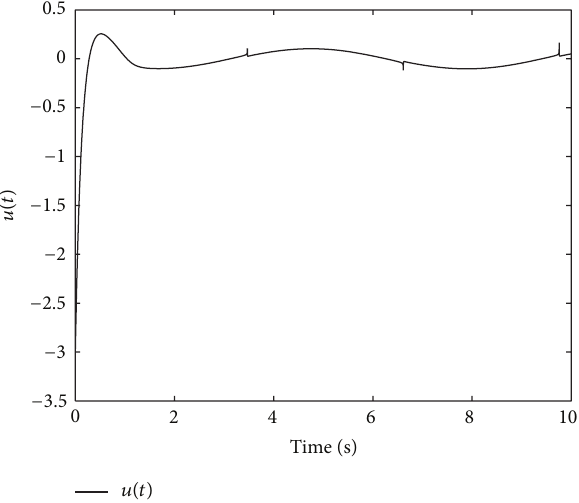
Figure4:Timeresponse 𝑢(𝑡) ofsystem(1)underthemethodof[20]. The states of controlled system (1) are shown in Figure 5.